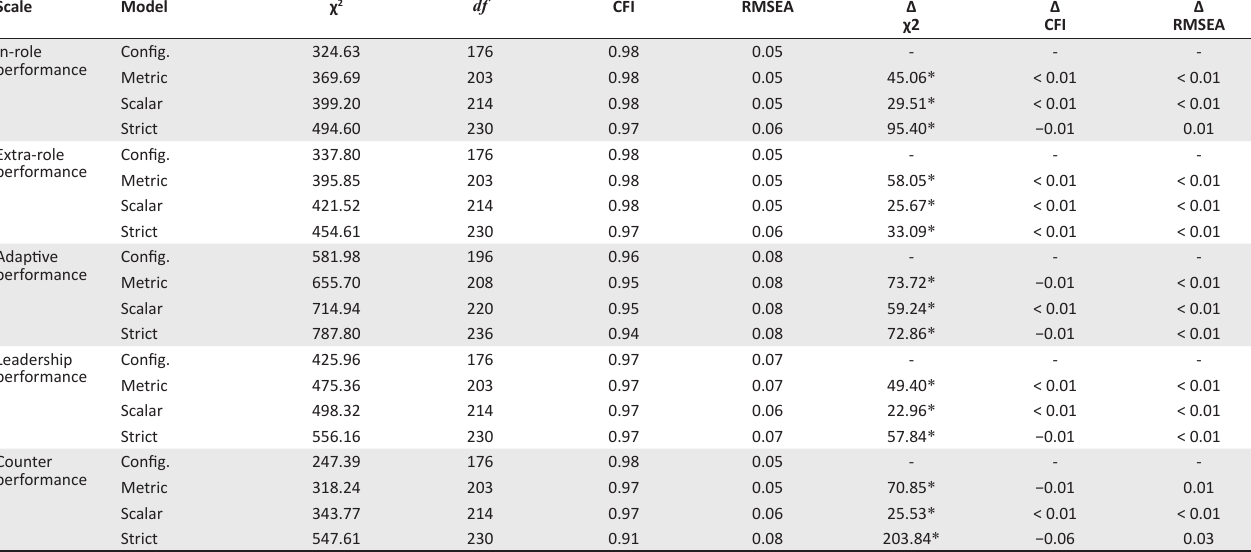
TABLE 3: Measurement invariance tests across ethnic groups on the individual work performance review bifactor models. Scale Model In-role